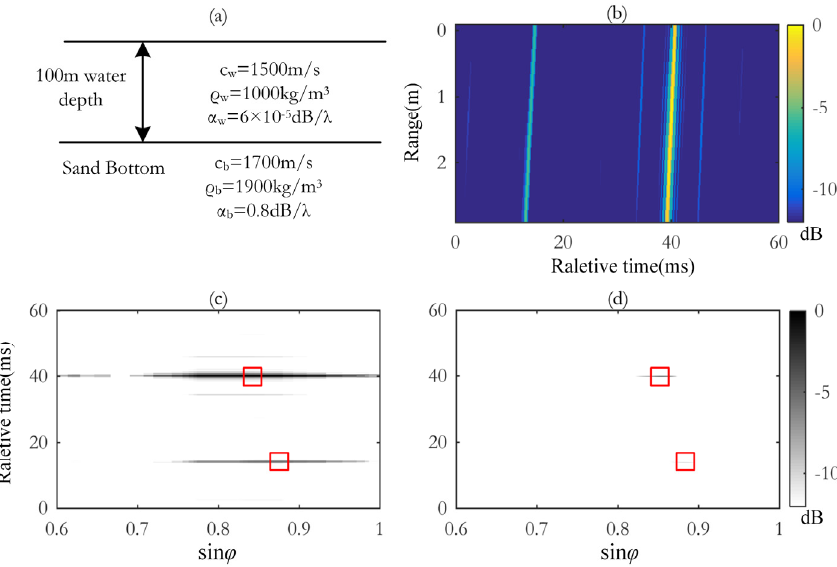
ρ , and α are the sound c , w w w ρ and α correspond to those c , b b b